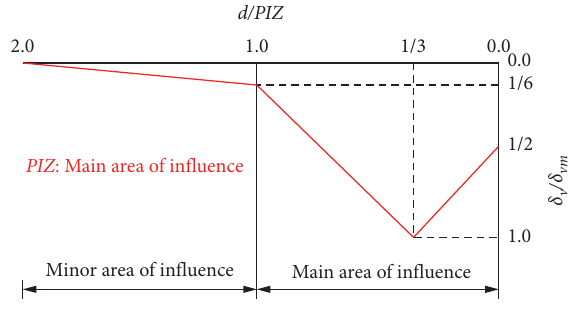
Figure 3: Surface settlement model.